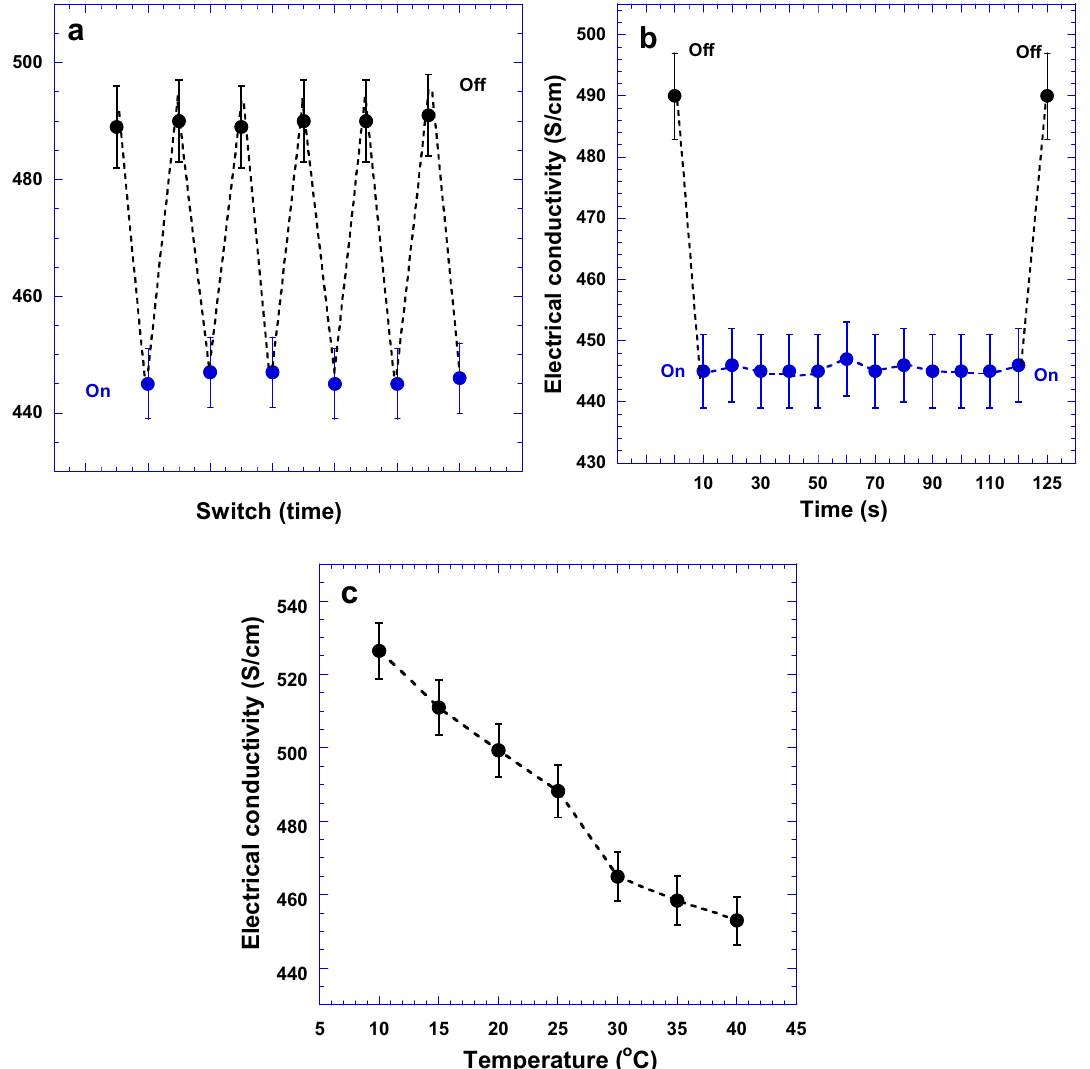
Figure 5. The electrical conductivities of the PEDOT:Tos thin films with the doping level of 43.6% ( a ) under the nitrogen flow pressure and under no nitrogen flow pressure, ( b ) under different flow times, and ( c ) under different temperatures without nitrogen flow